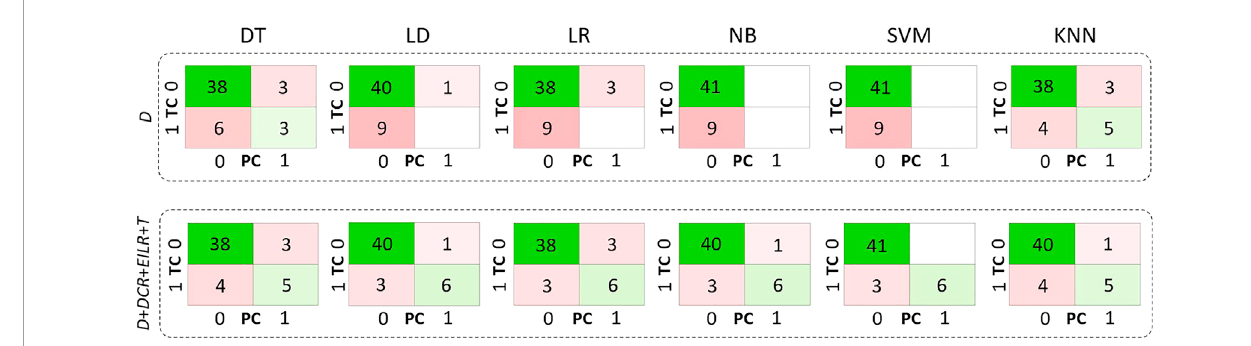
FIGURE 5 Confusion matrices related only to D on the first row and to D , DCR , EILR and T on the second row for the decision tree (DT), linear discriminant (LD), logistic regression (LR), naive bayes (NB), support vector machine (SVM), k-nearest neighbours (KNN) classifiers. TC means true class while PC means predicted